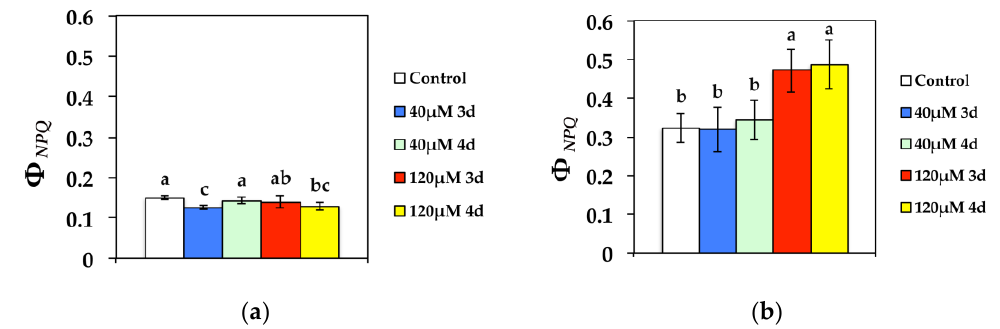
Figure 3. Changes in the quantum yield for dissipation by down regulation in PSII (regulated heat dissipation, a loss process serving for protection) ( Φ NPQ ) measured at ( a ) 300 μmol photons m −2 s −1 or ( b ) 1000 μmol photons m −2 s −1 . N. caerulescens plants were grown at 0 (control), 40, or 120 μ M Cd 2+ for 3 and 4 days.